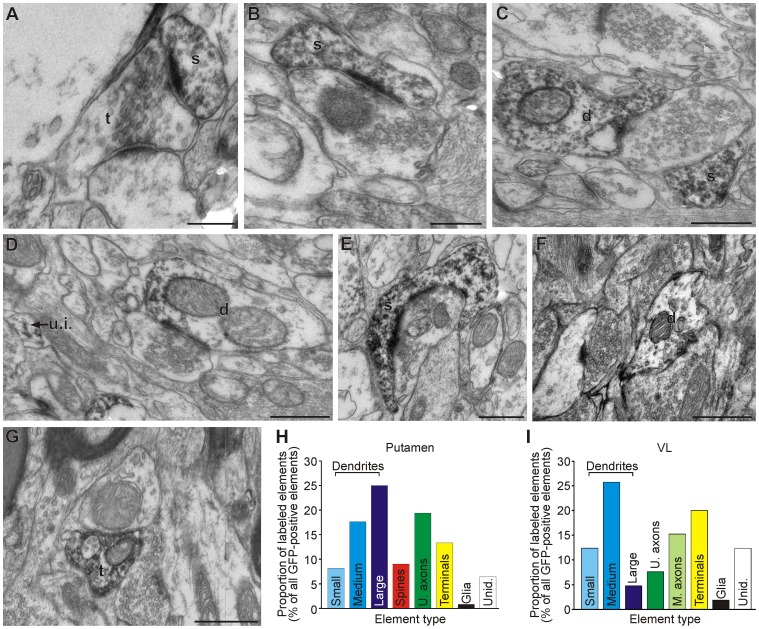
Channel rhodopsins are expressed in pre- and post-synaptic neuronal elements.A-E: Examples of eYFP-positive (ChR2 expressing) neuronal elements in the striatum (A-E, from monkey G) and VL (F, G, from monkey L). H and I: Proportion of immunolabeled elements in Putamen and VL. Scale bars: A-B, 0.25 µm; C-G: 0.5 µm. Abbreviations: d, dendrite; M. axons, myelinated axons; s, spine; U. axons, unmyelinated axons; t, terminal; u.i. or Unid., unidentified elements.